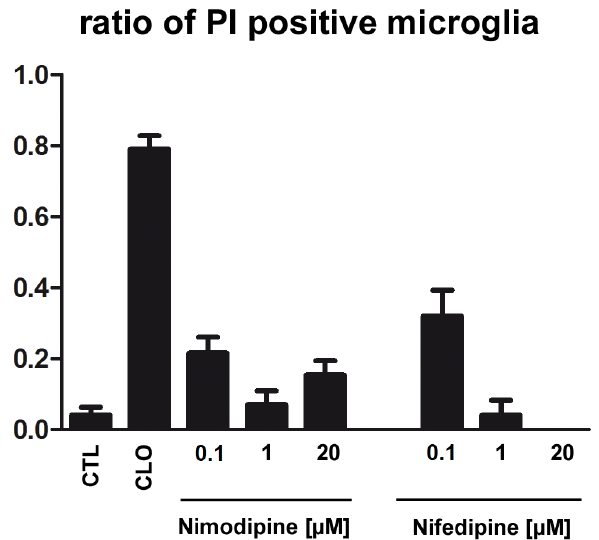
Figure 4. Effects of nimodipine or nifedipine on microglia cell death. The application of nimodipine (n 0.1 µ M = 21; n 1 µ M = 15; n 20 µ M = 17) or nifedipine (n 0.1 µ M = 13; n 1 µ M = 6; n 20 µ M = 7) had no effect on cell death in primary microglia (5000). Clodronate (n CLO = 59) increased the number of damaged microglia in comparison to CTL (n CTL = 25) with typical changes in morphology, whereas nimodipine or nifedipine had no effect on cell death. Data from three independent experiments are presented as mean with SEM. * depict statistically significant results with p < 0.05.